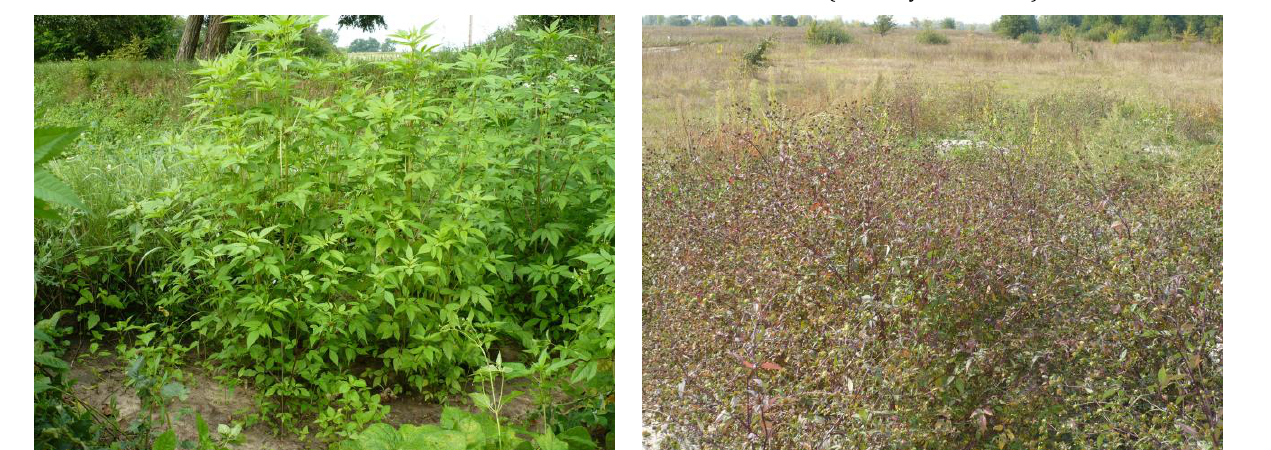
Fig. 8. Junco bufonii-Bidentetum connatae in the dried reclamation canal (near the village of Astei, Beregiv district, Zakarpattia region, 14.07.2012) (Photo by L. Felbaba-Klushyna)